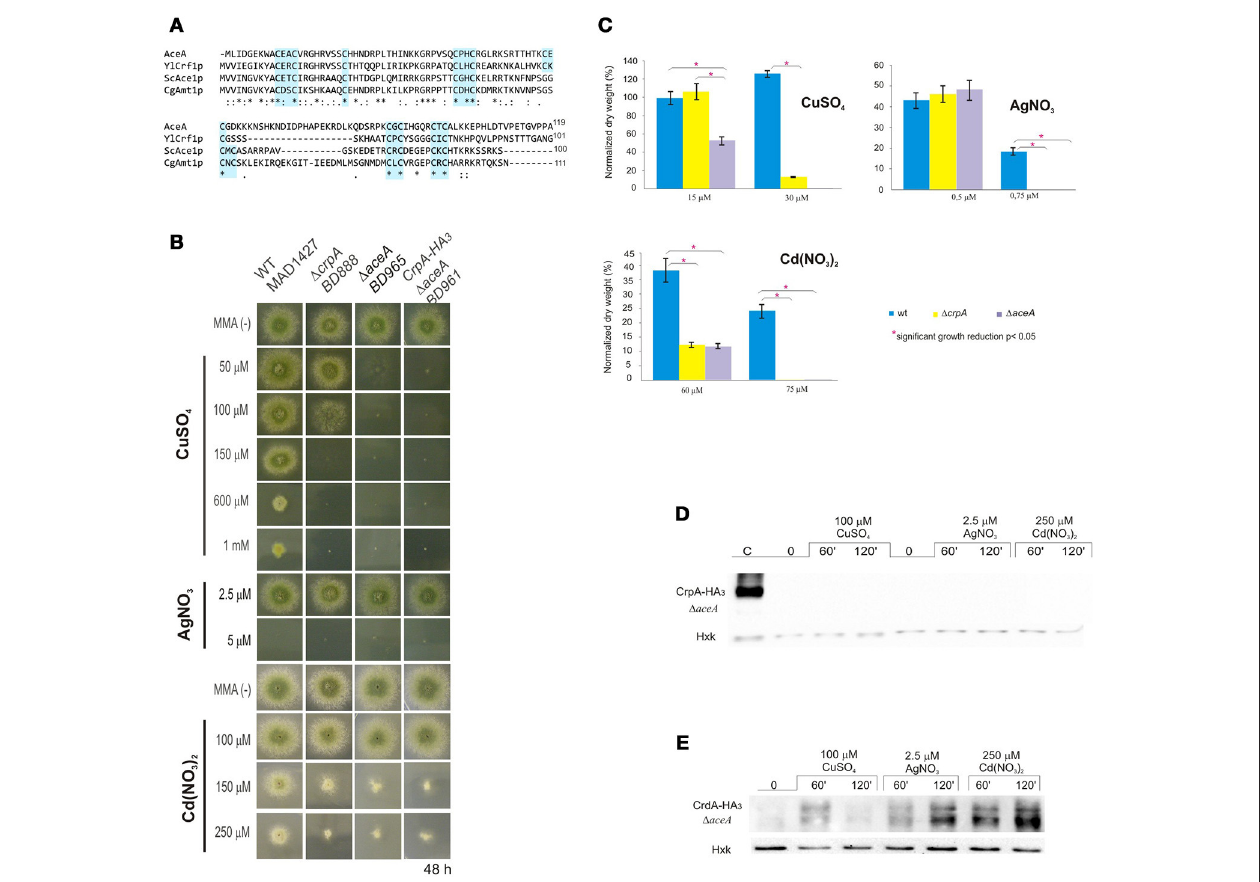
FIGURE 5 | Functional analysis of AceA. (A) Multiple alignment of the most conserved region, N-terminal half, of AceA, YlCrf1p, ScAce1p, and CgAmt1p, which contains the majority of cysteine residues arranged in clusters (indicated in light blue boxes). Protein alignments were performed using Clustal Omega. Genebank protein accesion numbers are as follows: A . nidulans AceA (CBF85835.1), Y. lipolytica YlCrf1p (XP_500631.1), S. cerevisiae ScAce1p (CAA96877.1), and C. glabrata CgAmt1p (XP_447430.1). (B) ∆ aceA mutant characterization in solid medium supplemented with indicated concentrations of CuSO 4 , AgNO 3 , and Cd(NO 3 ) 2 . (C) Biomass measurement of WT, ∆ aceA and ∆ crpA strains grown at indicated conditions. Data was normalized and presented as percentages. Bars indicate means and error bars standard deviation. N = 3. Western blot showing (D) CrpA-HA 3 and (E) CrdA-HA 3 induction by heavy metal ions in a null aceA background strain. Hexokinase and CrpA-HA 3 sample of cells treated for 1 h with copper were used as controls. *Significant growth reduction p <